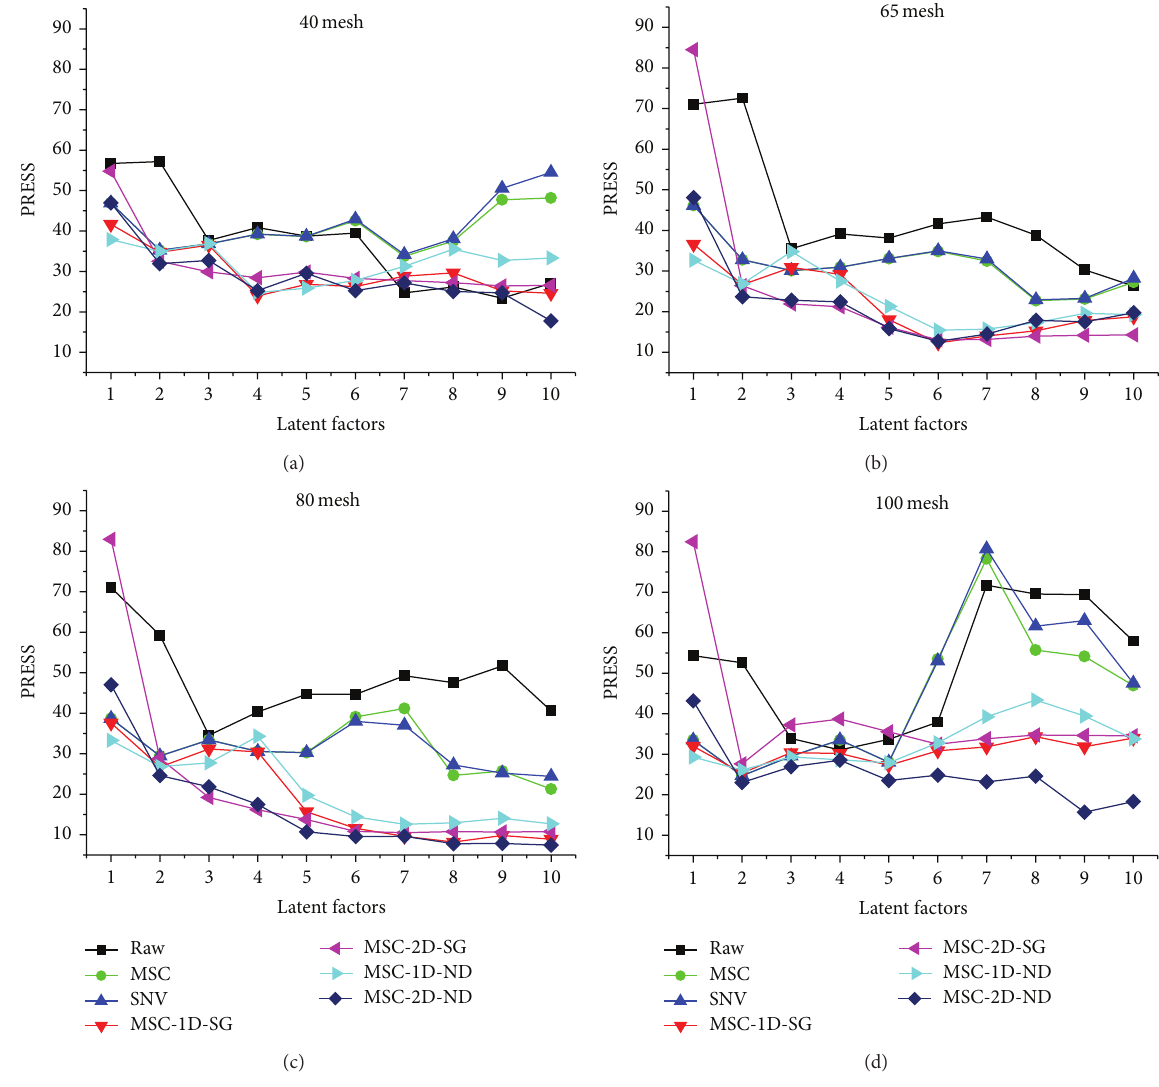
Figure 3: Plot of PRESS value against latent factors.